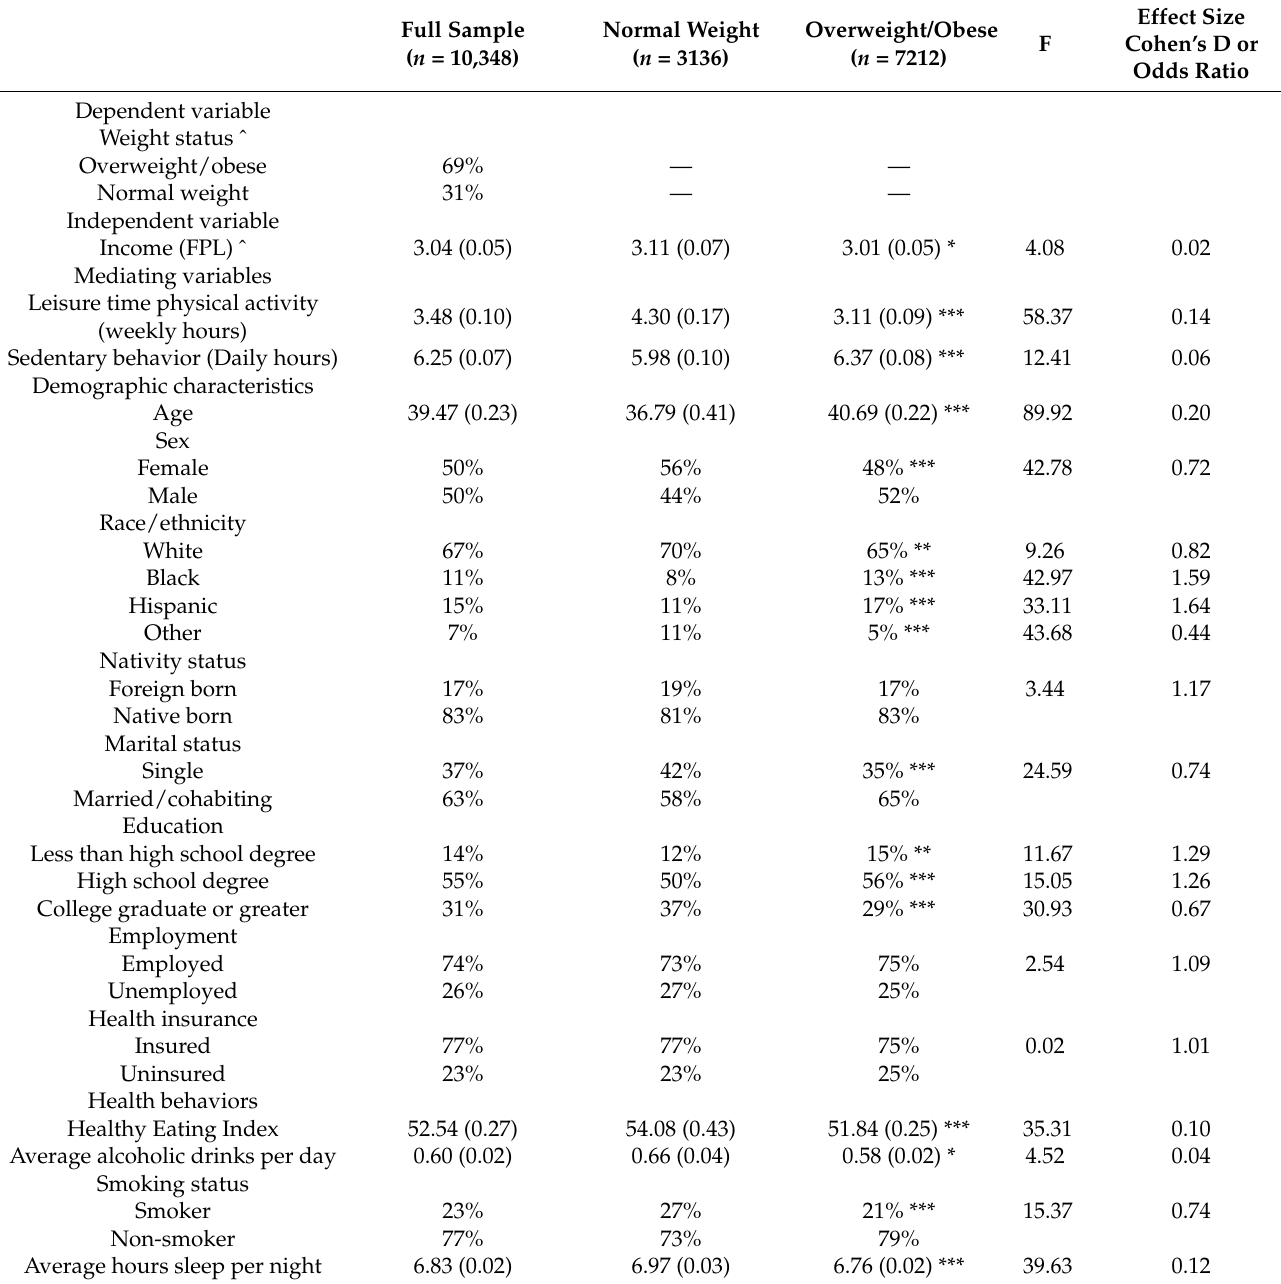
Table 1. Characteristics of participants by weight status: National Health and Nutrition Examination Survey 2007–2014, M (SE) or %.